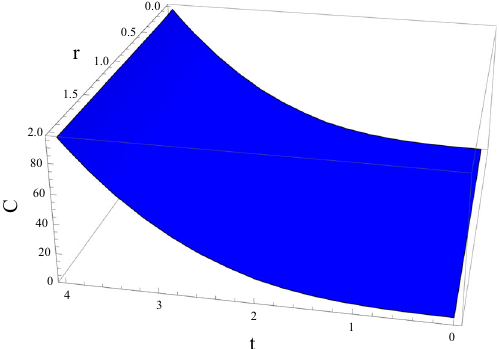
Fig. 1 The plot is for κ < 0 , m = 1 . 4 and s = 0 . 5 that corresponds to